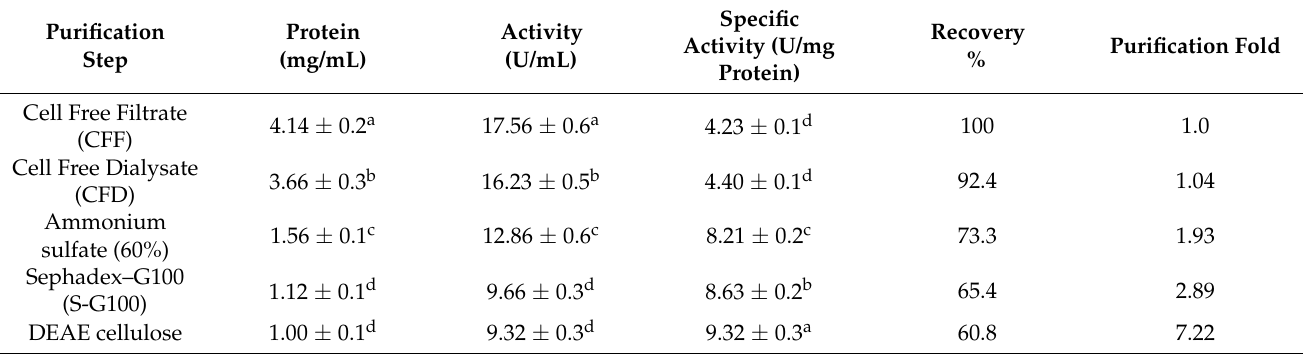
Table 2. Purification of chitinase from T. funiculosus strain CBS 129594.